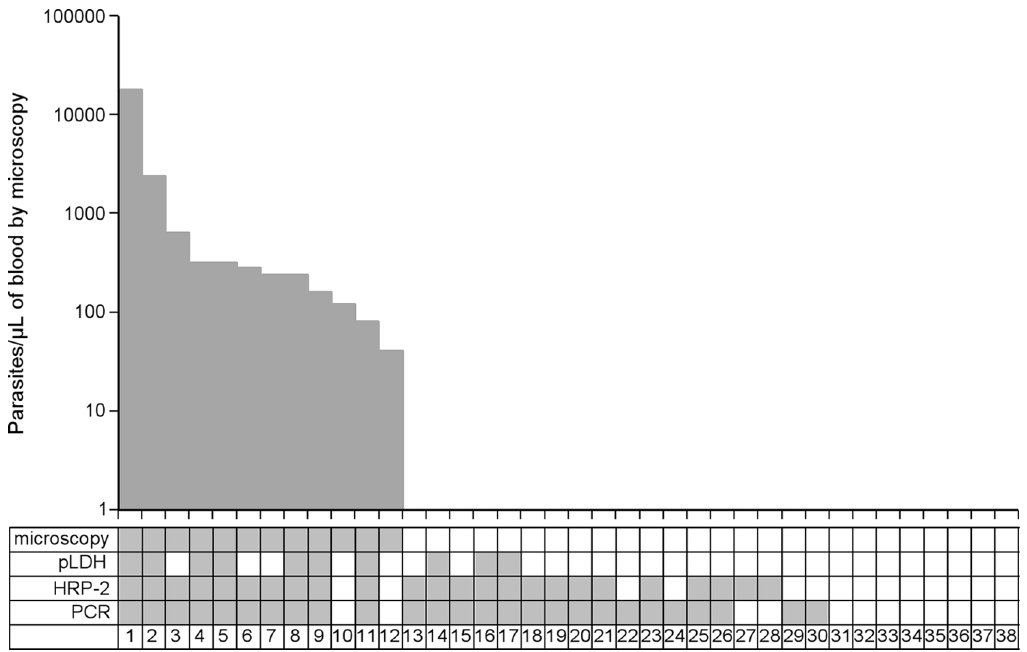
Figure 2. Comparison of routine microscopy, p LDH/ Pf HRP-2 ELISA and qPCR for a group of study participants who had acute blood smears prepared at sick visits. Each column (1–38) represents one blood sample with the corresponding microscopy, p LDH/ Pf HRP-2 ELISA and qRT-PCR results, ordered by parasite density as determined by microscopy (top graph) and antigen levels ( p LDH/ Pf HRP-2) or Ct values (qPCR). As the levels of parasitemia decreases, the concordance between the different methods also decreases. Pf HRP-2 and qPCR detect parasites densities way beyond the detection limit of microscopy.